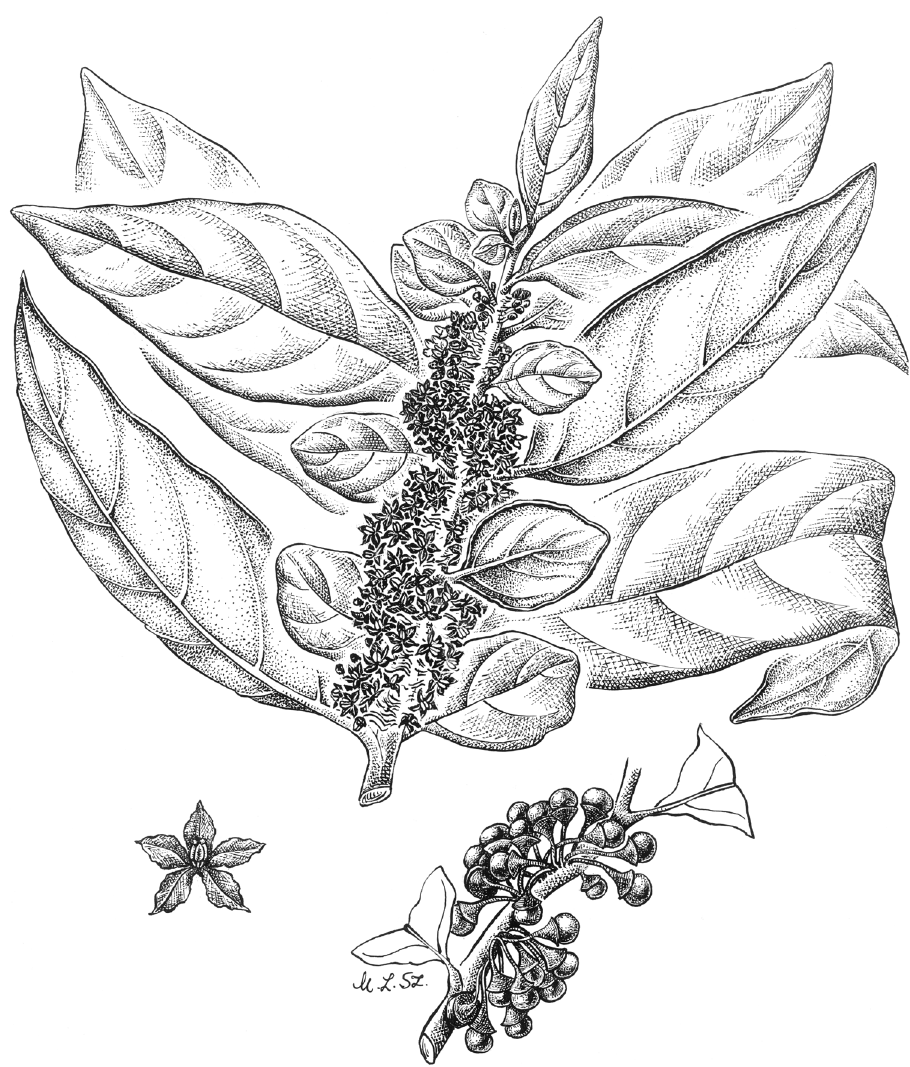
Figure 25. Lycianthes kaernbachii (Lauterb. & K.Schum.) Bitter. Drawing by M.L. Szent-Ivany, first published in Symon (1985: fig. 13, as S. kaernbachii Lauterb. & K.Schum.). Courtesy of the Board of the Botanic Gardens and State Herbarium (Adelaide, South Australia), reproduced with